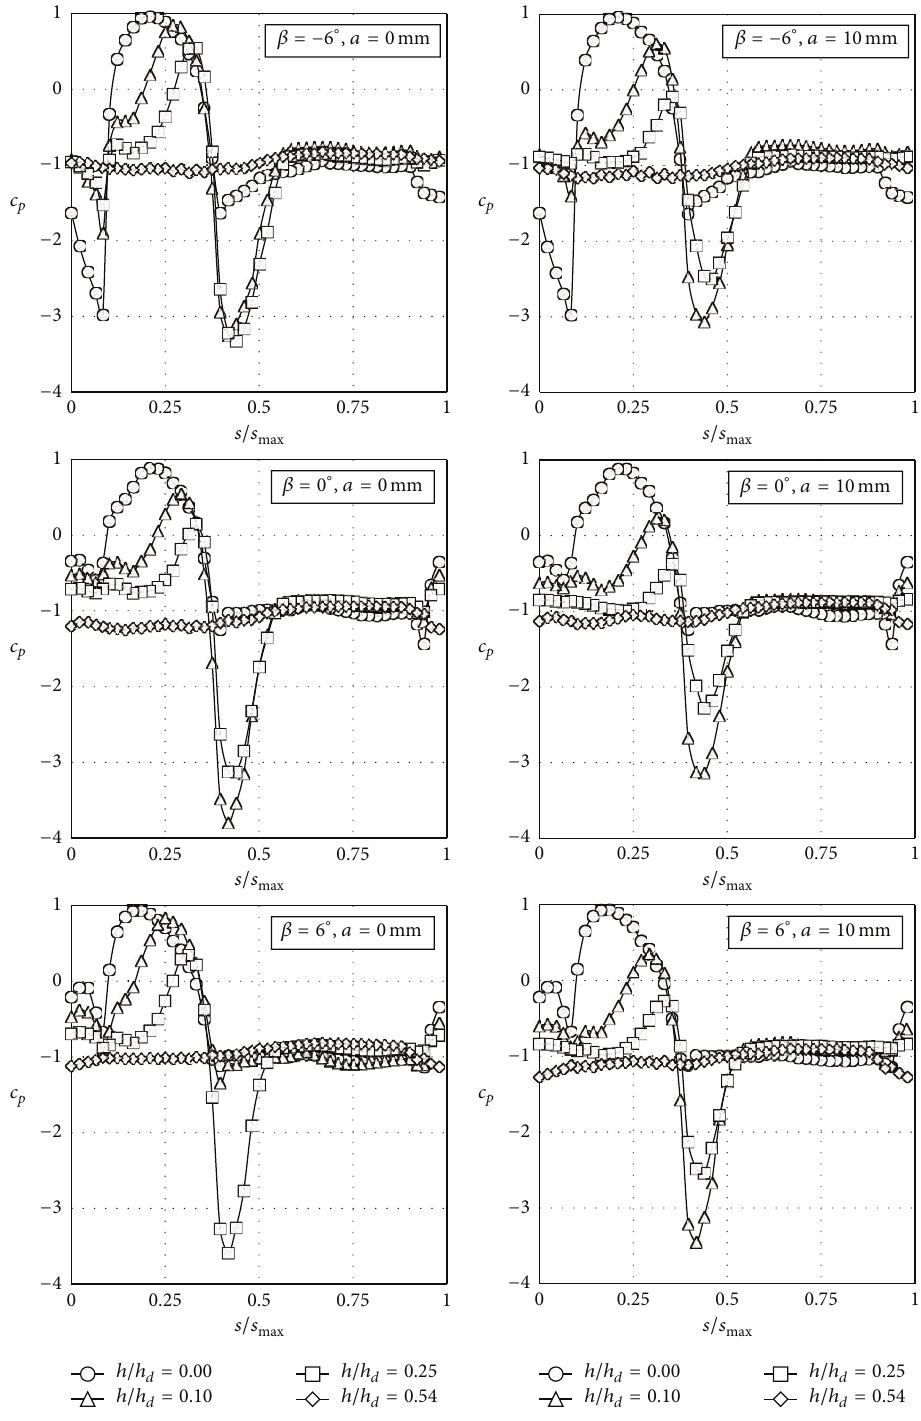
Figure 9: Pressure coefficient, 𝑐 𝑝 , distributions with the coach placed on the windward railway track on an embankment with a slope 1:1, as a function of the nondimensional distance over the train surface at the middle cross-section, 𝑠/𝑠 max (see Figure